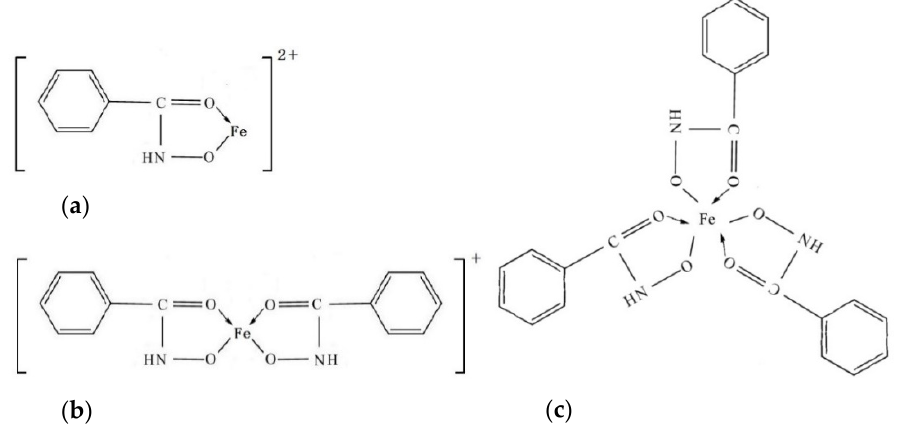
Figure 6. The main existence forms of the Fe-BHA chelates in solution. ( a ) BHA:Fe=1:1; ( b ) BHA:Fe=2:1; ( c )